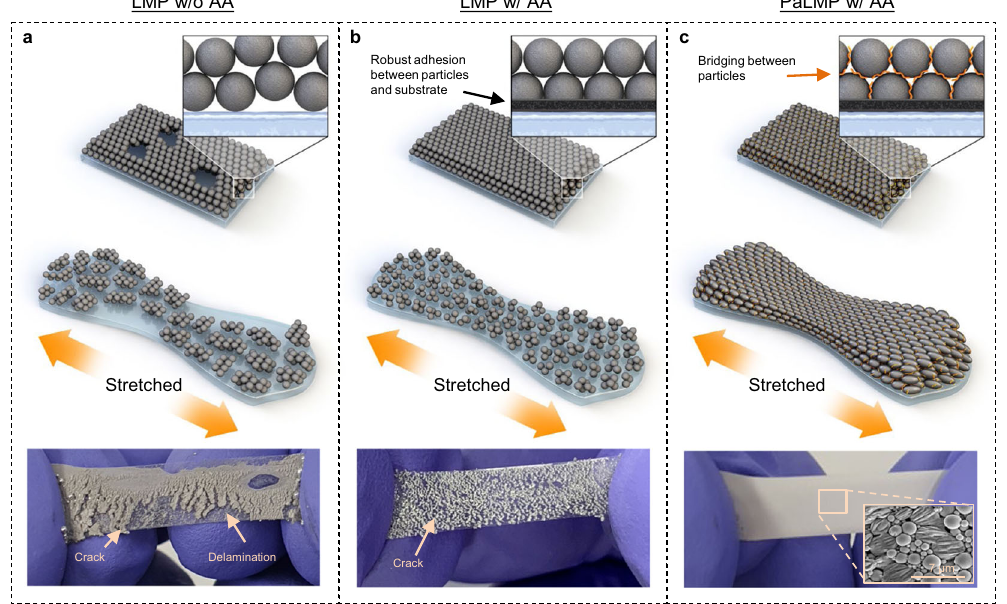
Fig. 4 Stretchability of coated LMP according to combinations of additives. a Schematic illustration and photograph of coated LMPs without AA under application of strain. Severe delamination and cracks are observed. b Schematic illustration and photograph of coated LMPs with AA under application of strain. c Schematic illustration, photograph, and SEM image of printed PaLMPs with AA under application of strain. There are no observed delamination or PDMS substrate. The fi lm prepared with an ink absent of both AA in enhancing the adhesion of LMP-based fi lm onto the AA and PSS cracked and delaminated from the substrate under substrate. For the fi lm generated with an ink containing both AA strain (Fig. 4a). For the fi lm made with an AA-containing ink and PSS, the fi lm neither cracked nor delaminated under strain without PSS, it adhered well onto PDMS; however, the fi lm (Fig. 4c). SEM image con fi rms elongation of particle without cracked under strain (Fig. 4b). These results recon fi rm the role of rupturing after strain (see Fig. 5c below for repeated strain cycle).